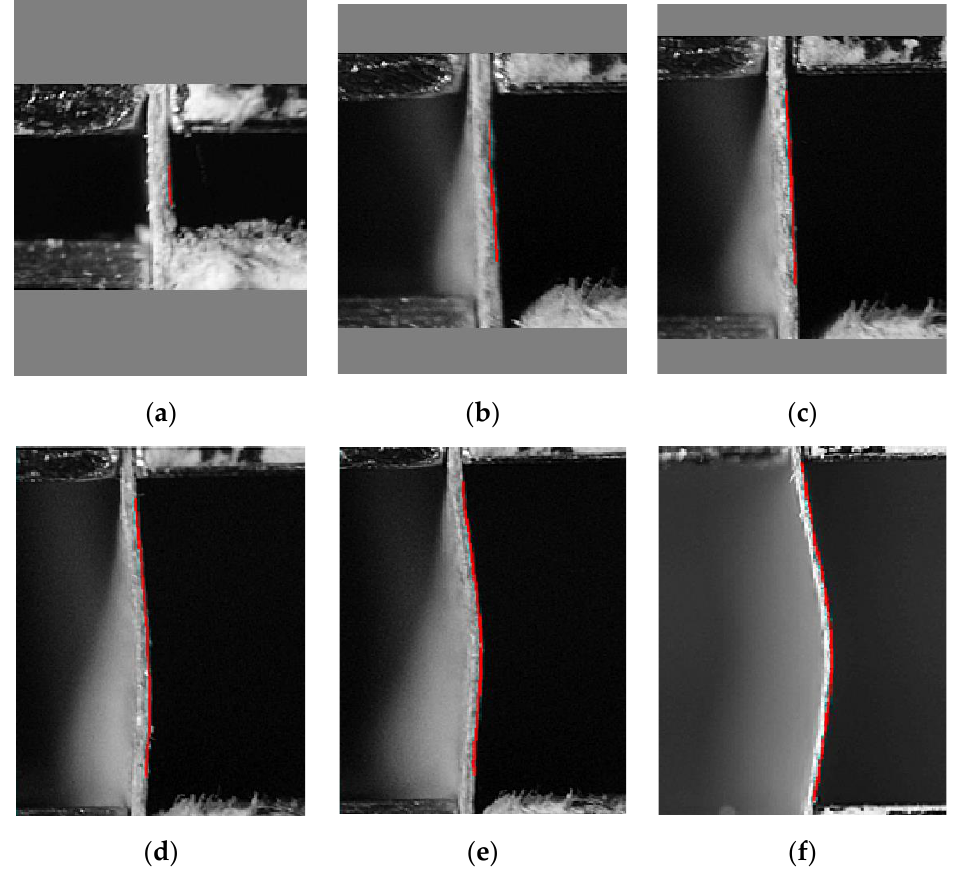
Figure 13. Shape of the edge of the compressed paper sample when the maximum force is reached at the clamping lengths: ( a ) 0.7 mm, ( b ) 1.3 mm, ( c ) 2 mm, ( d ) 3 mm, ( e ) 4 mm, ( f ) 5 mm.